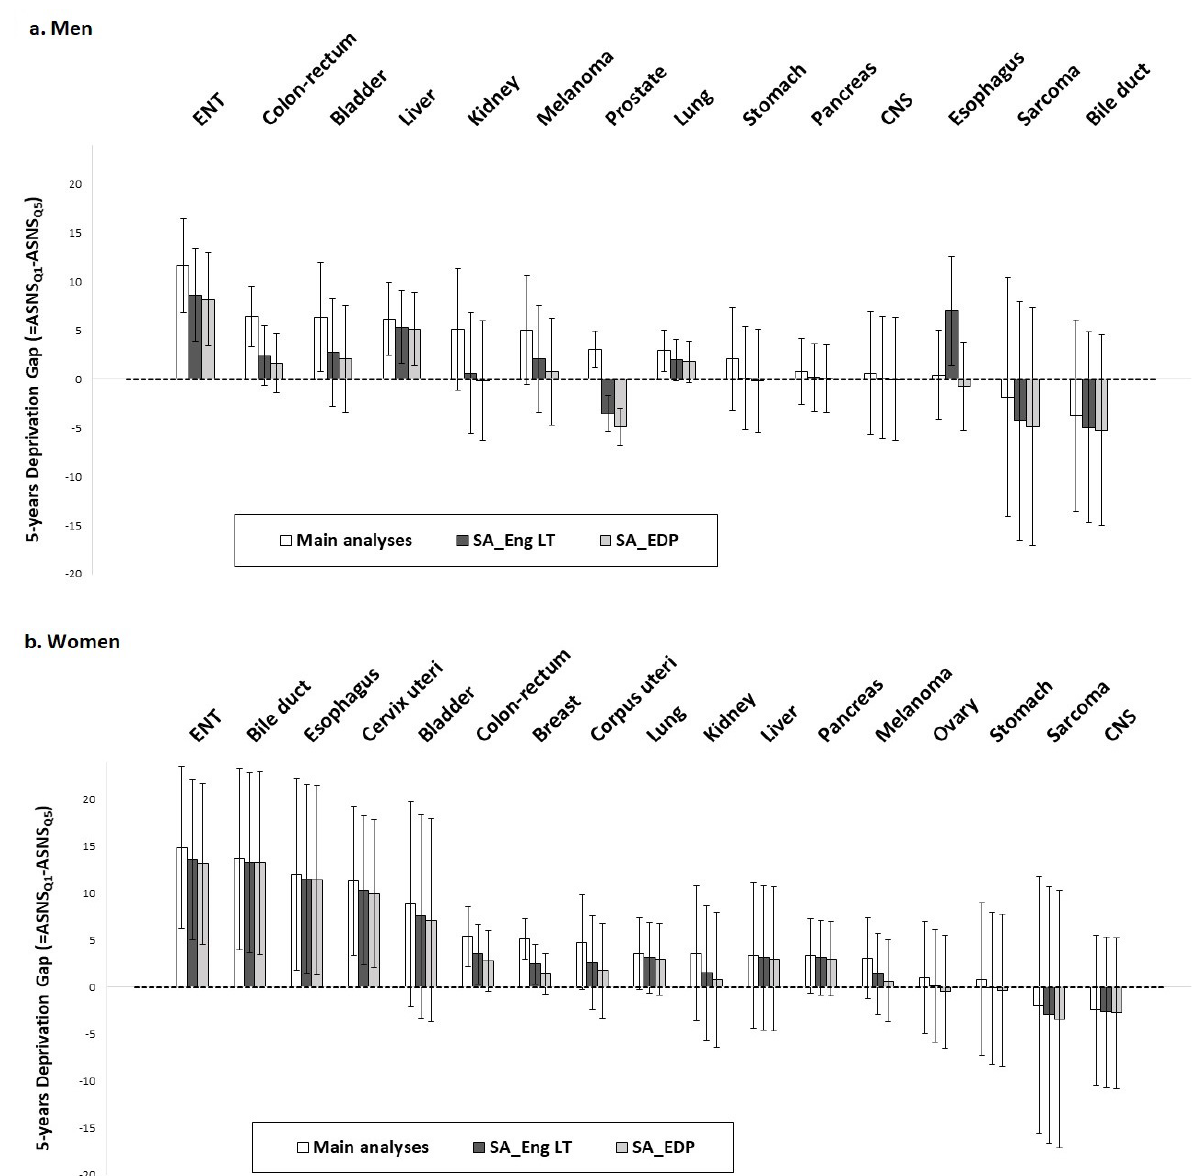
Figure 1. Difference in 5-year age-standardized net survival (ASNS) between patients living in least-deprived environment (Q1) and patients living in most-deprived environment (Q5) (i.e., 5-Year Deprivation Gap), estimated by non-parametric Pohar–Perme method, for men ( a ) and women ( b ), for each cancer site, according to main analyses, sensitivity analyses using English life tables (SA_Eng LT), and sensitivity analyses using EDP data (SA_EDP). ASNS: age-standardized net survival; CNS: central nervous system; EDI: European Deprivation Index; EDP: French permanent demographic sample [Echantillon D é mographique Permanent]; ENT: ear, neck, throat (head